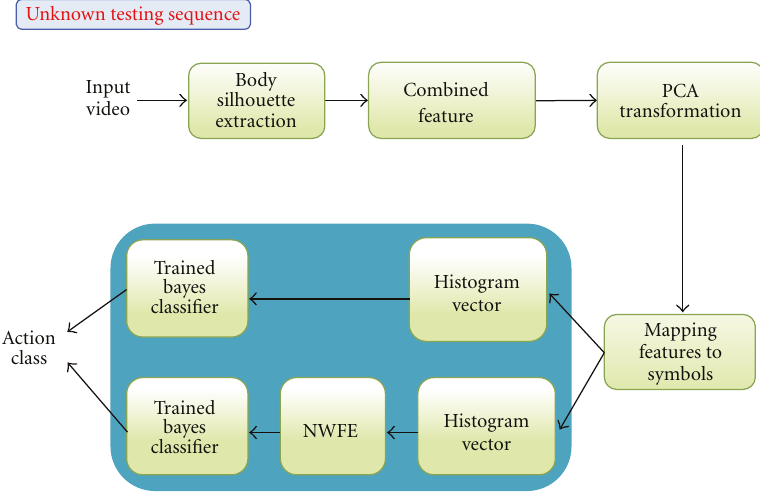
Figure 12: The flowchart of the proposed system, with and without performing NWFE.